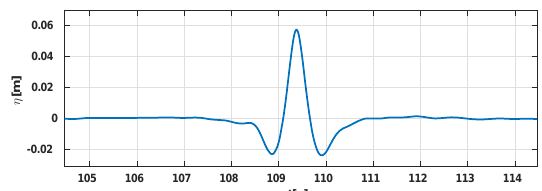
Figure 10. Case 202002. Zoomed version of the maximal wave; the crest height is 4.65m and the wave height is 6.56 times the signifi- cant wave height.